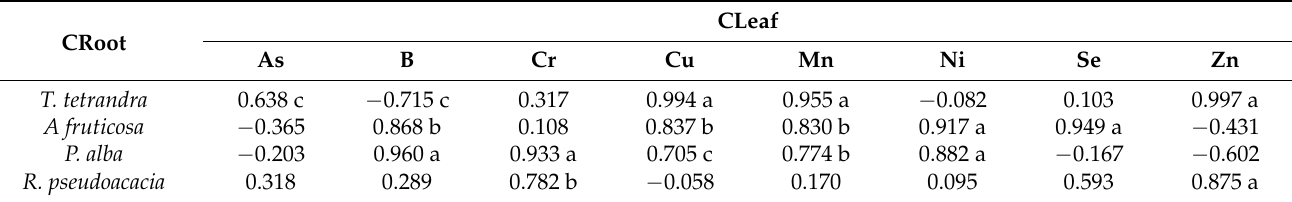
Table 4. Spearman’s correlation coefficient between trace element concentrations in the roots (CRoot) and leaves (CLeaf) of the examined woody plant